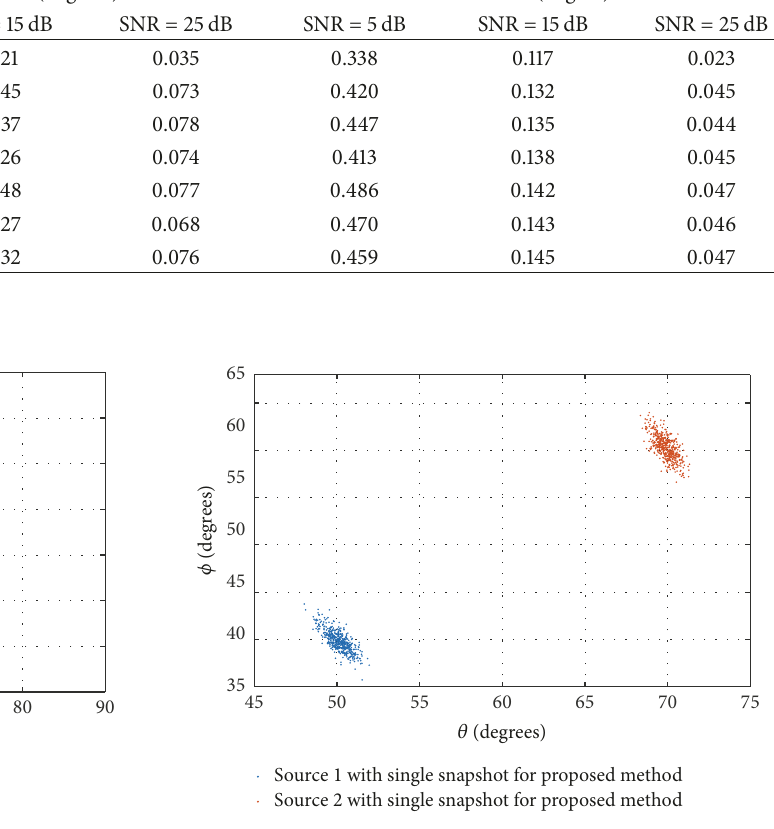
Figure 12: Scatter plot for the proposed method in the presence of two coherent sources located at (𝜃 1 = 40 ∘ ,𝜙 1 = 50 ∘ ) and (𝜃 2 = 60 ∘ ,𝜙 = 70 ∘ ) with SNR = 0dB and single snapshot. 2